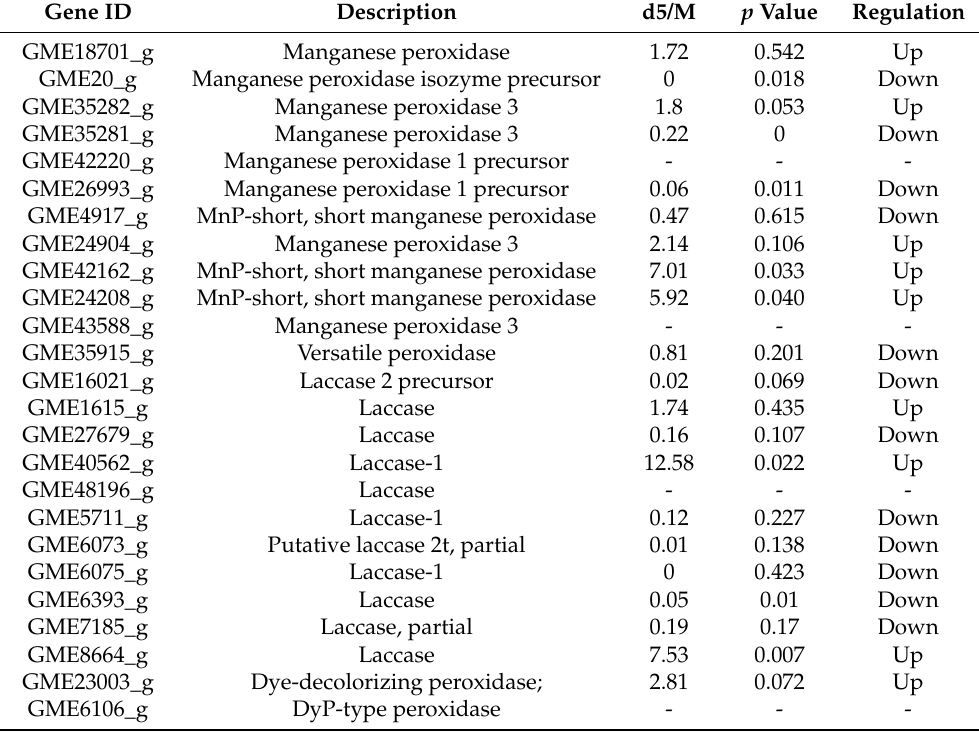
Table 1. Transcriptome expression levels (FPKM) of 25 lignin-modifying enzyme genes on the 5th day (d5) of the coculture versus the pure culture (M) of Mycena sp.